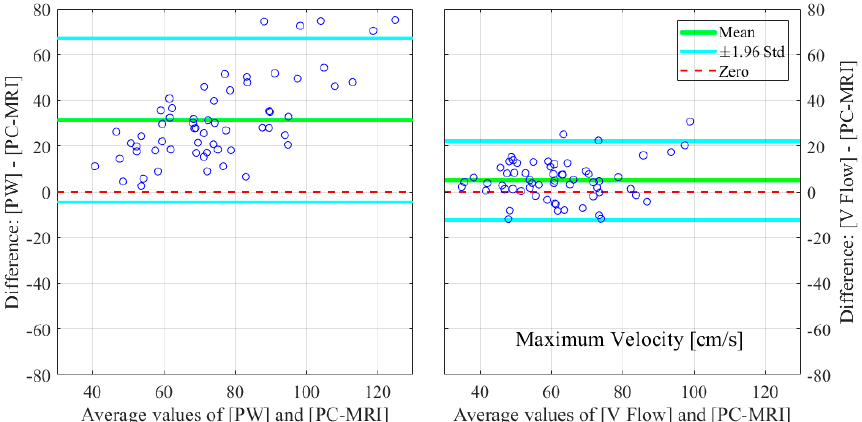
Figure 6. Bland–Altman plots for illustrating the differences in the estimated maximum velocities for PW and V Flow relative to PC-MRI.